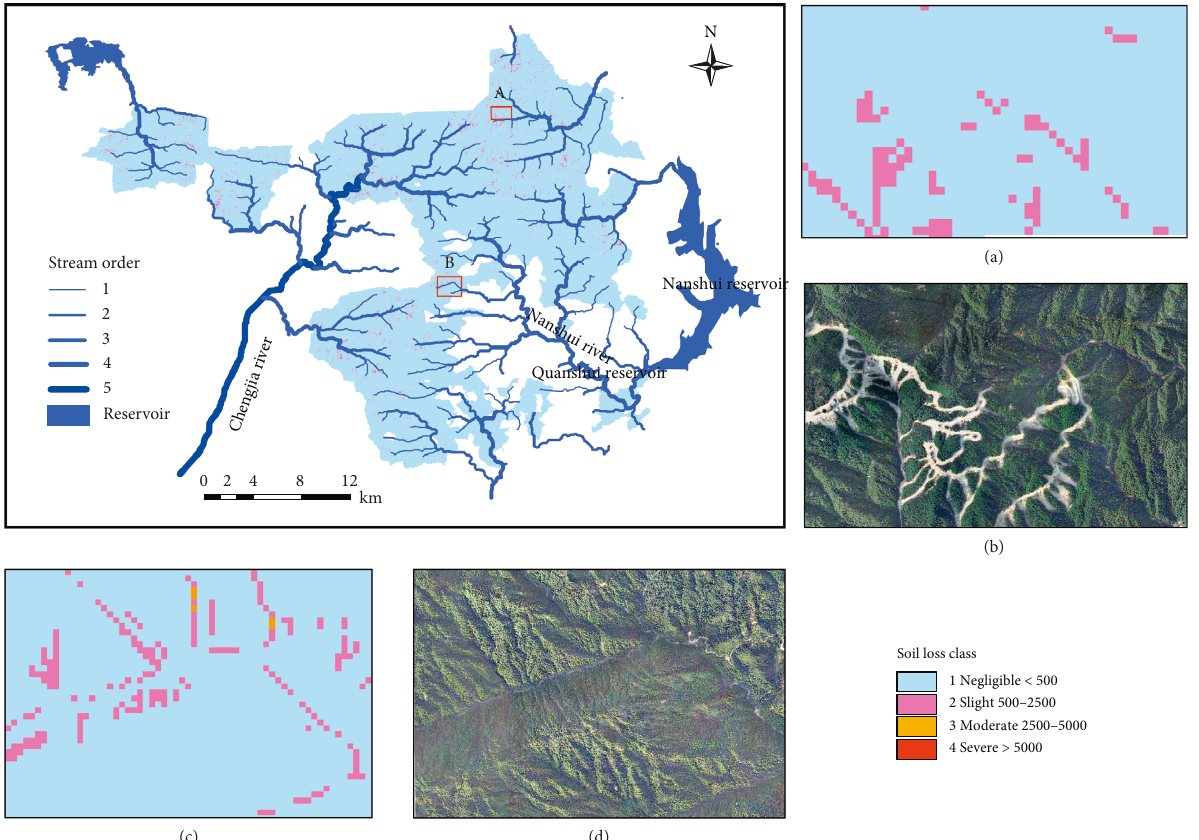
Figure 7: The comparison between the result derived from RUSLE and the remote sensing images: (a) RUSLE result of site A; (b) the remote sensing image of site A; (c) RUSLE result of site B; and (d) the remote sensing image of site